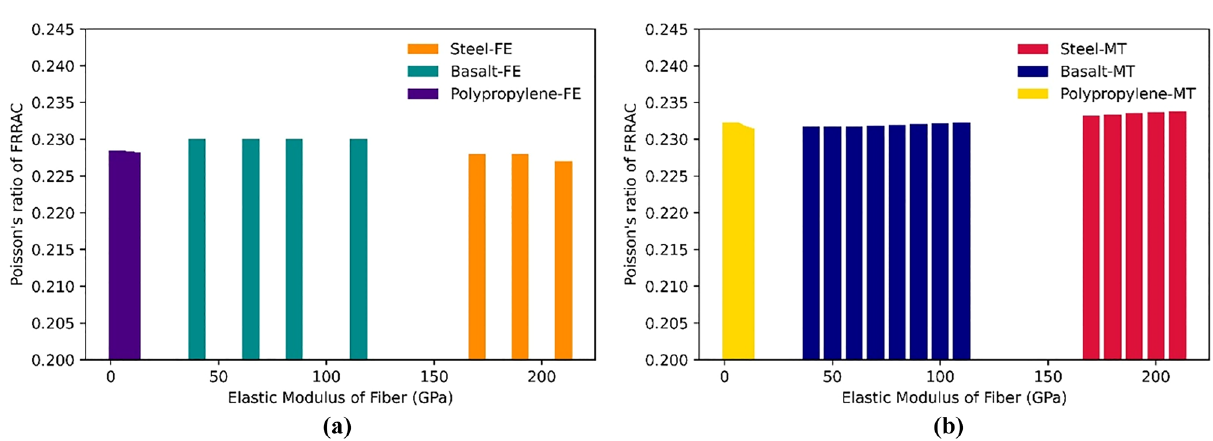
Figure 12. The Poisson’s ratio of FRRAC based on fiber elastic modulus: ( a ) FE approach, ( b ) MT